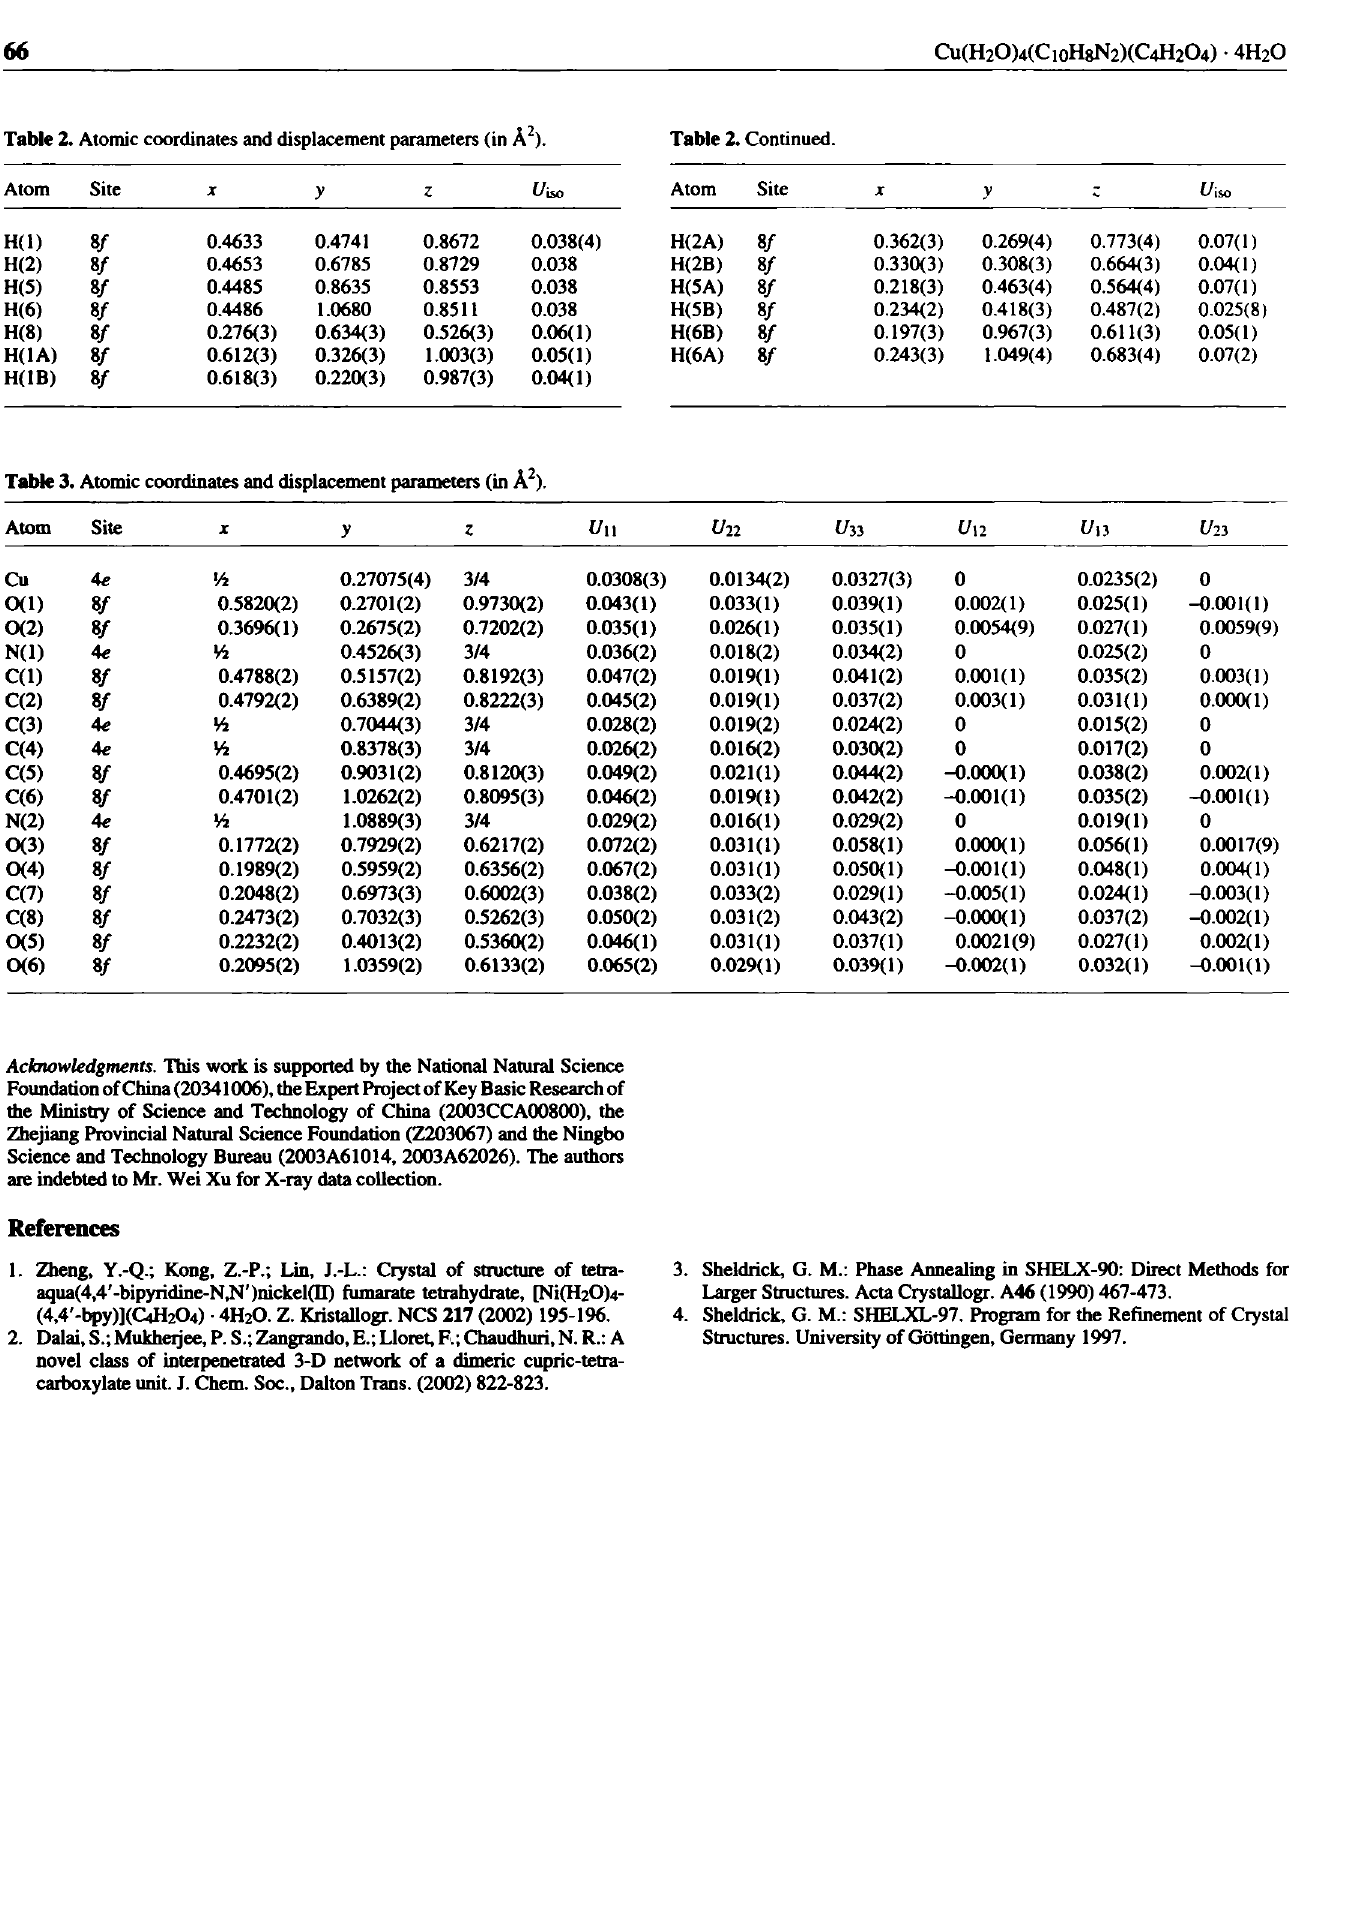
Table 2. Atomic coordinates and displacement parameters (in Â 2 ). Table 2. Continued.